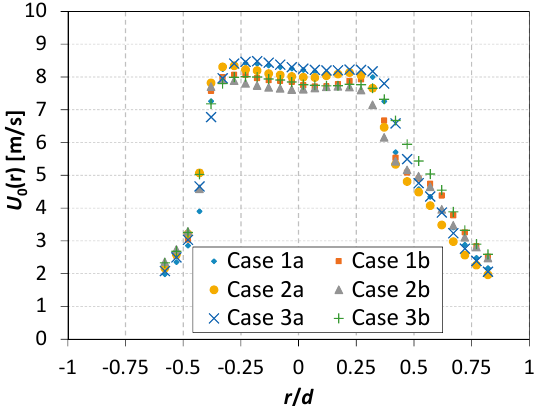
Figure 6. The momentum velocity profiles for the characteristic frequency, P = 4 W, x / d = 0.1.